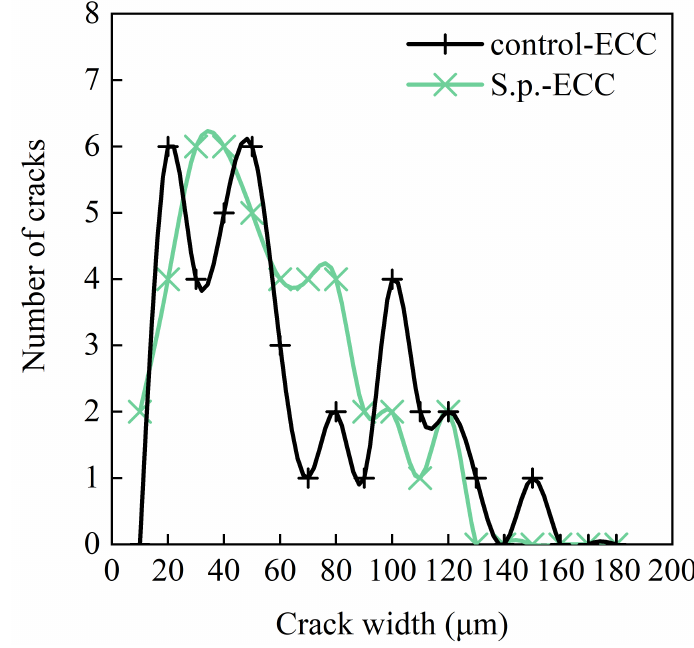
Figure 14. Crack width distribution in